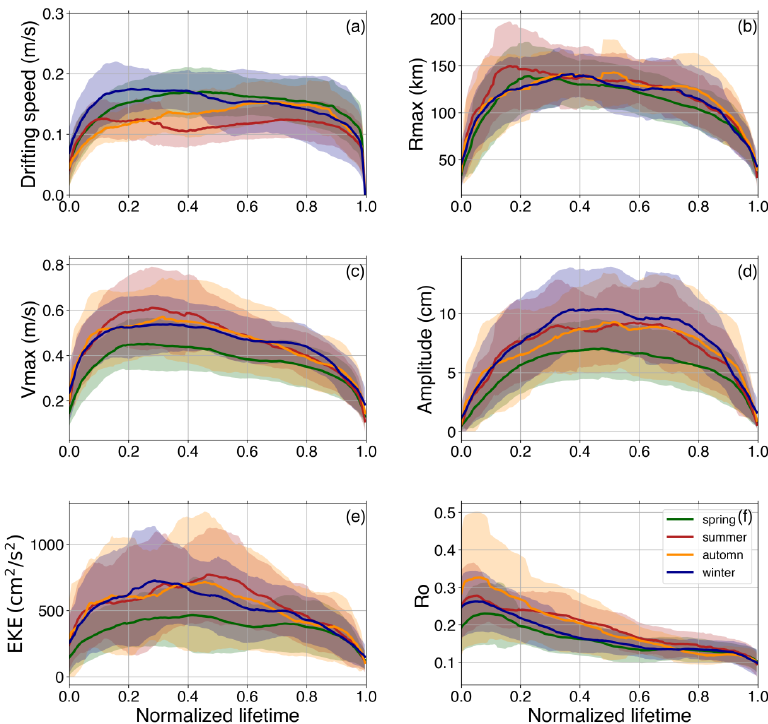
Figure 13. Ensemble mean and standard deviation of NBC ring parameters for each season as a func- tion of a normalized lifetime. ( a ) translation speed, ( b ) Radius max ( c ) Velocity max, ( d ) Amplitude, ( e ) Kinetic energy, ( f ) Rossby number.